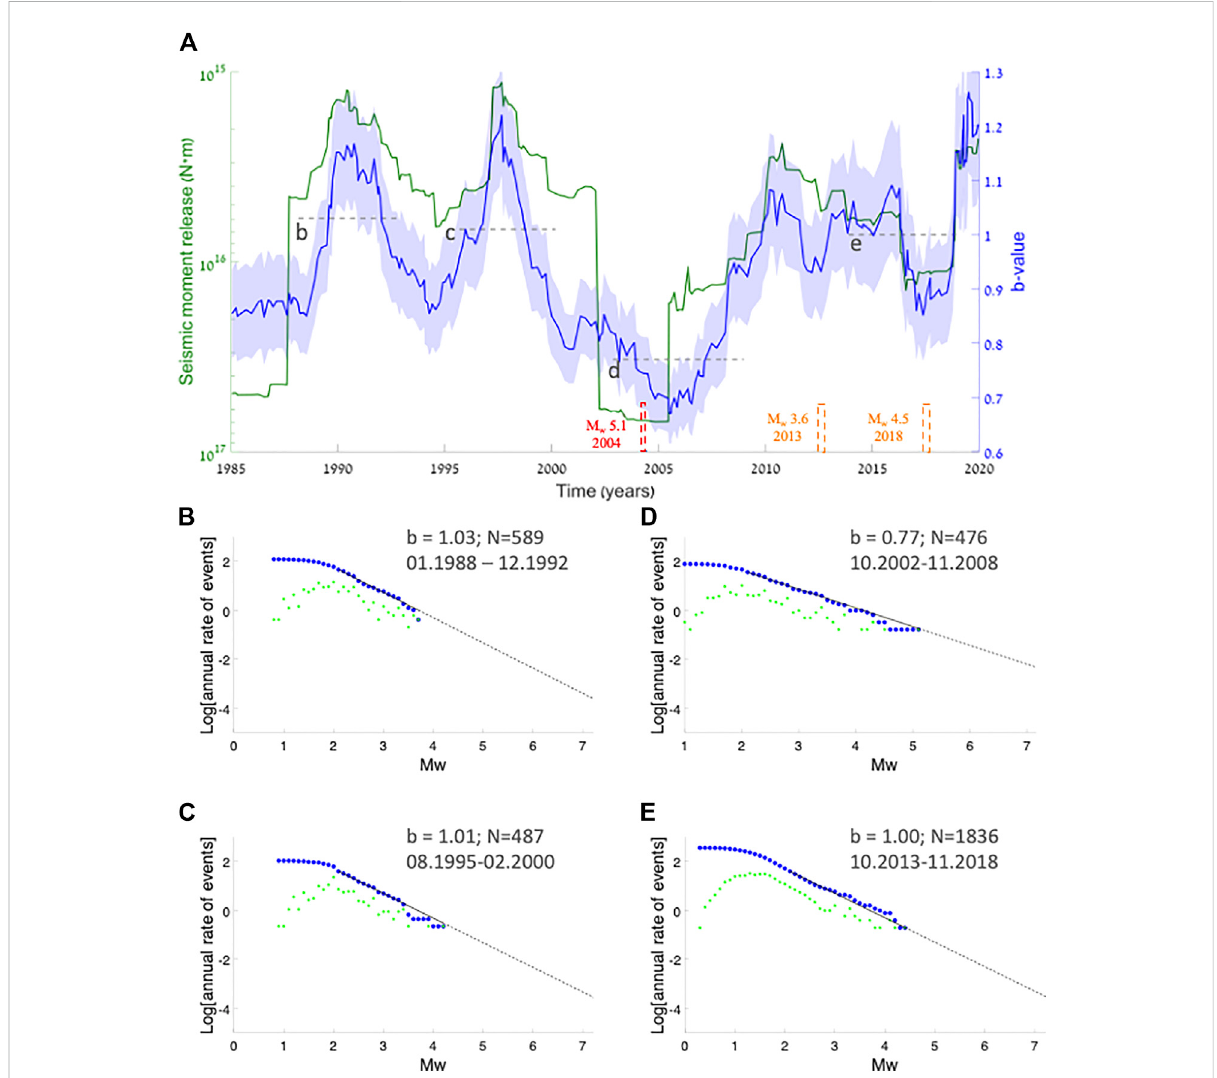
FIGURE 8 (A) Temporal variations of the b-value (in blue) with their light blue error bar band around them, and of the cumulative seismic moment release (in green; note the axis on the left is directed downwards) in the DST (Figures 5, 7), based on 100-event time windows in 5-event intervals. Also marked are the b-values calculated for speci fi c time-windows [ (B – E) ; dashed grey lines], verifying the fl uctuations seen in the b-value pro fi le; their frequency magnitude curves are presented in panel 8 (B – E) . Two reductions of the b-value can be related to swarm activities at the Sea of Galilee, during 2013 and 2018 (dashed orange rectangles; Wetzler et al.,